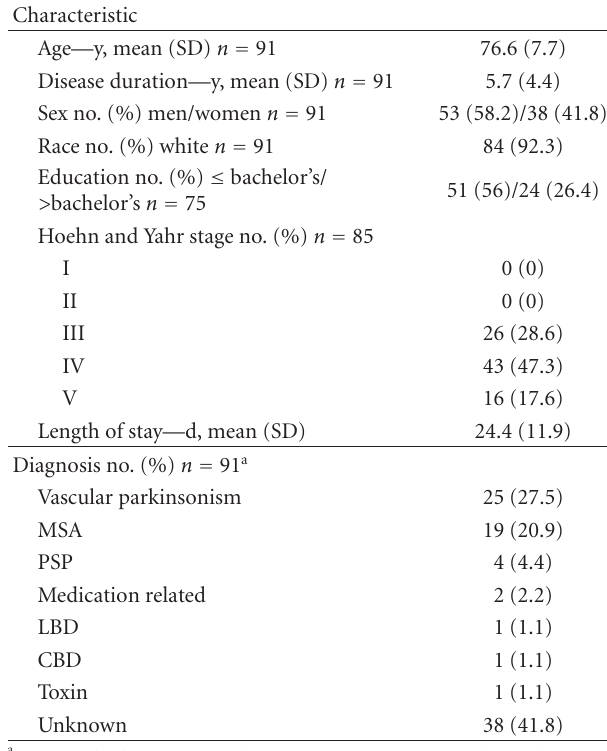
Table 1: Patient baseline